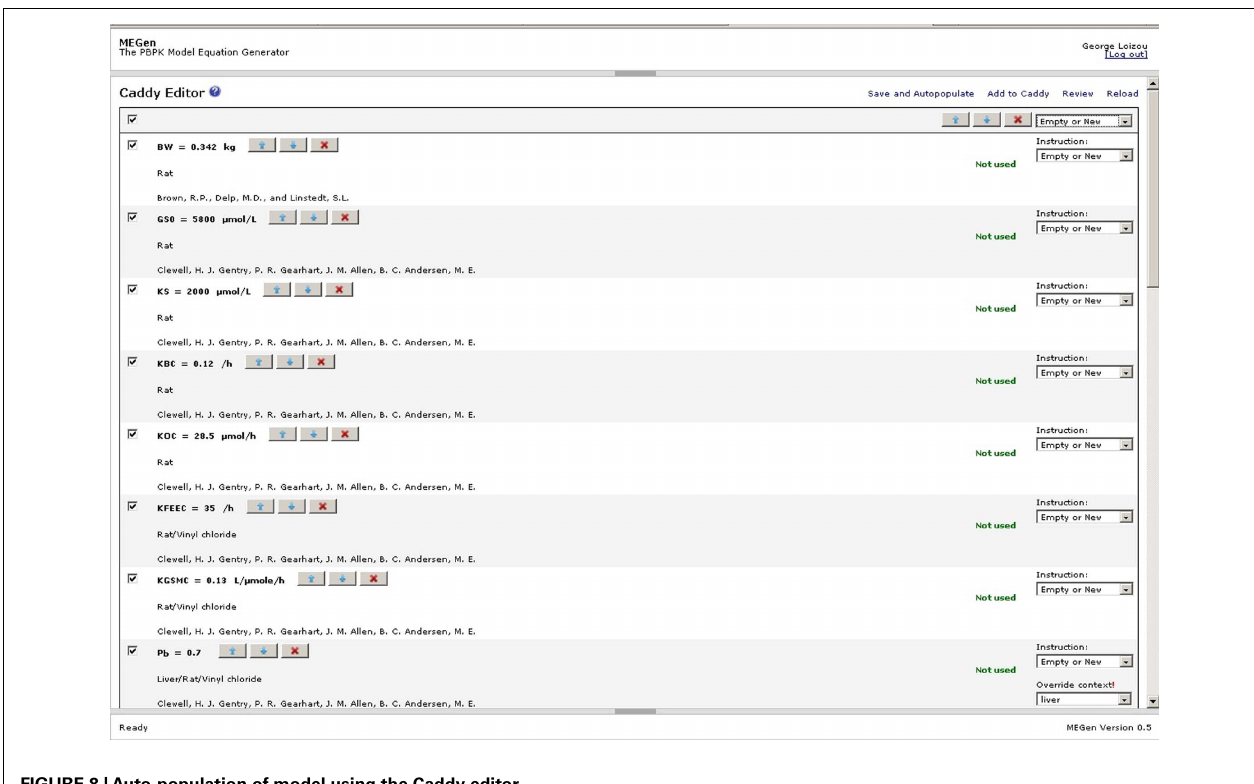
FIGURE 8 |Auto-population of model using the Caddy editor.